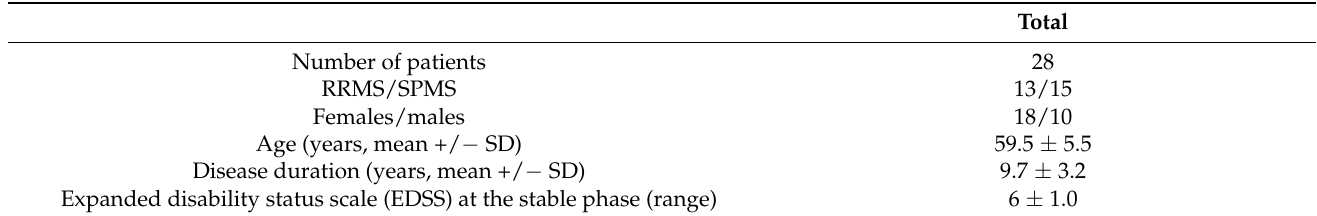
Table 1. Clinical characteristics of the 13 patients with relapsing-remitting multiple sclerosis (RRMS) and 15 patients with secondary progressive multiple sclerosis